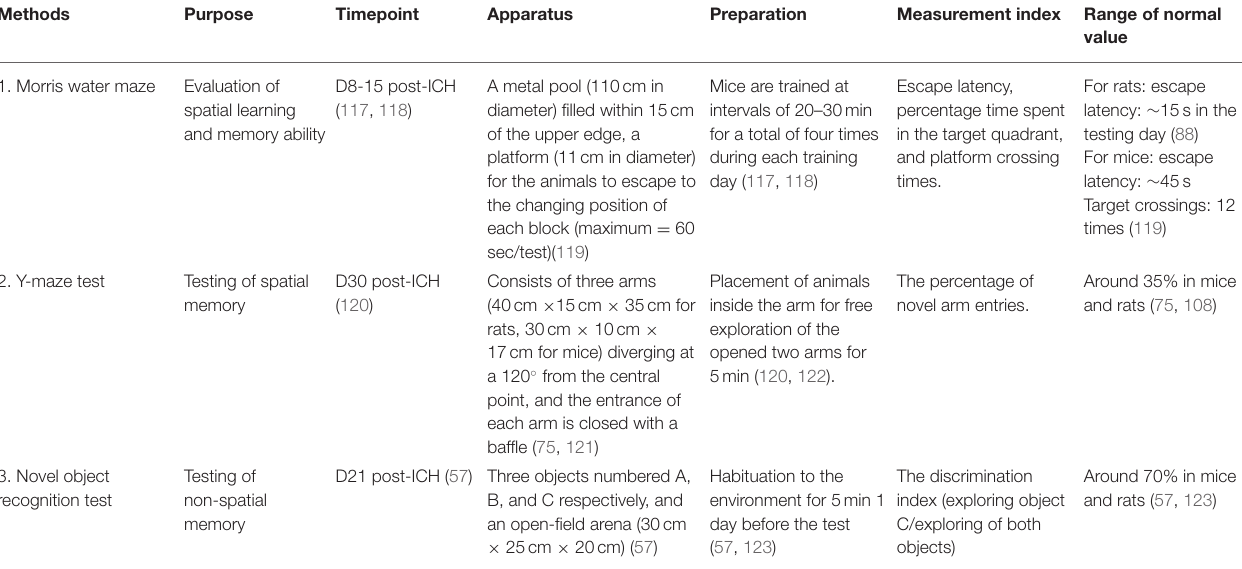
TABLE 4 | Cognition